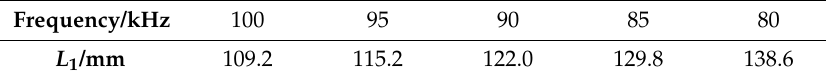
Table 2. The interval L 1 for each frequency in the experiment.